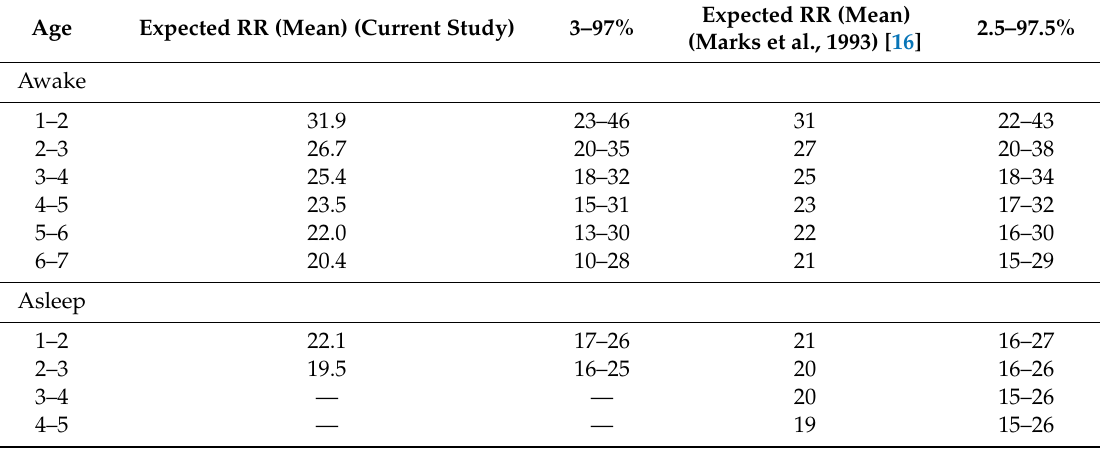
Table 6. Comparison of RR data from current study and study by Marks et al. [16] (1st Centile, Median and 99th